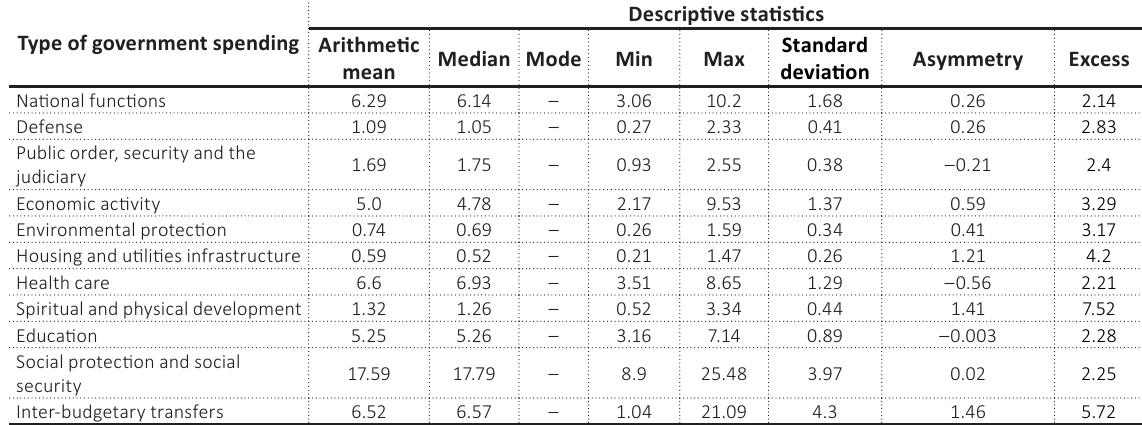
Figure 3. Density of distribution of public expenditures in the EU by item in 2010–2018 (the y-axis shows the density, the x-axis shows the options) Table 3. Descriptive statistics of government spending in the EU, 2010–2018 Source: Authors’